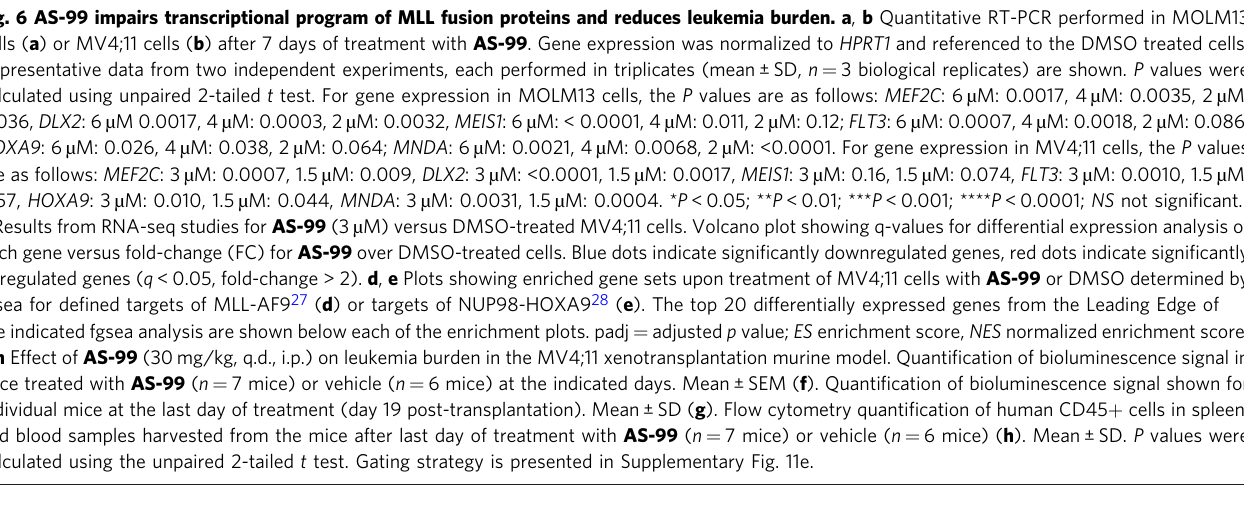
Fig. 6 AS-99 impairs transcriptional program of MLL fusion proteins and reduces leukemia burden. a , b Quantitative RT-PCR performed in MOLM13 cells ( a ) or MV4;11 cells ( b ) after 7 days of treatment with AS-99 . Gene expression was normalized to HPRT1 and referenced to the DMSO treated